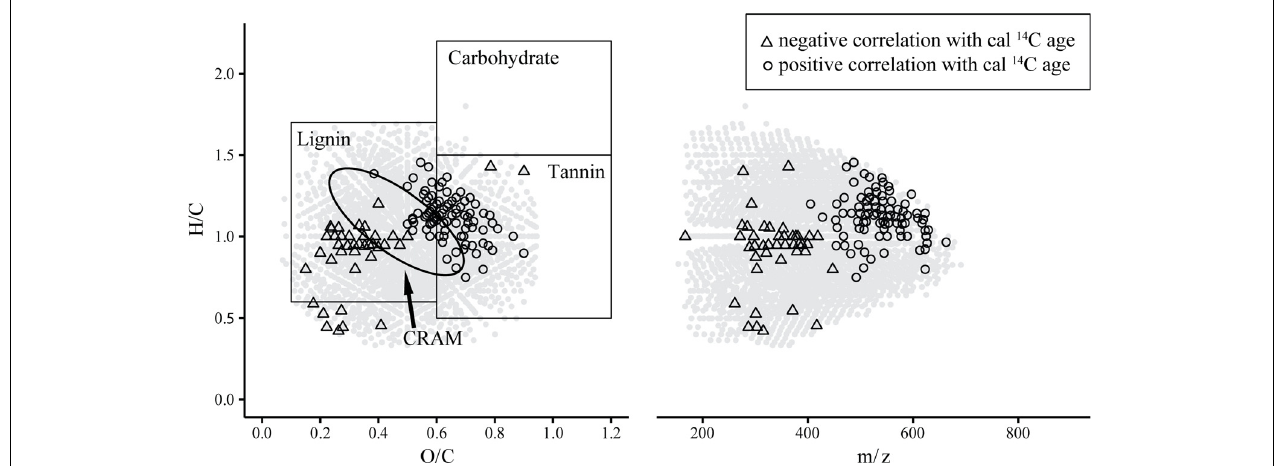
FIGURE 3 | Van Krevelen and m/z plots highlighting sum formulae that were significantly ( p < 0.05) positively or negatively correlated to cal 14 C age. Circles in gray represent all sum formulae that were detected in at least 8 out of 10 samples. Structure suggestions in the van Krevelen diagram adapted from Antony et al. (2014).